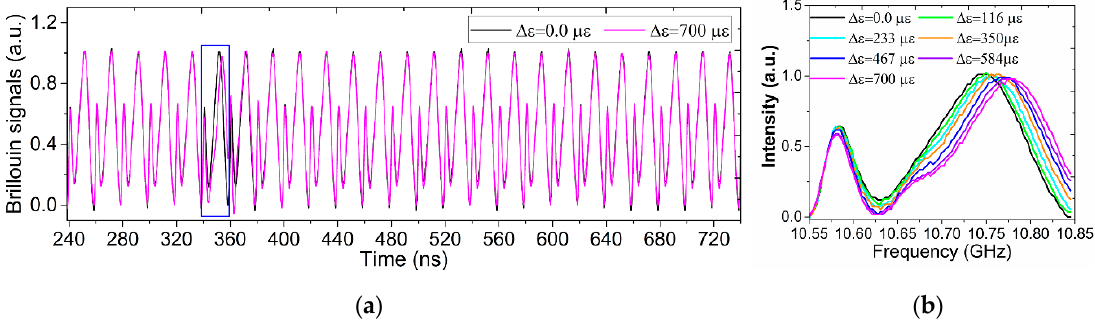
Figure 15. The static strain measurement [1]. ( a ) The time traces and ( b ) the BGSs for a series of strains.